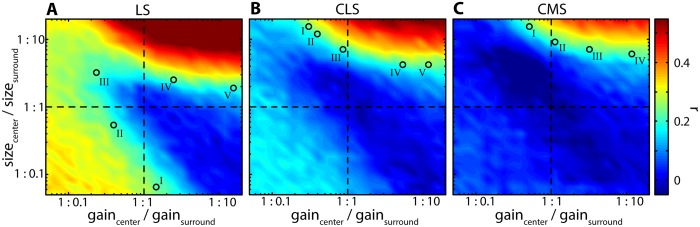
Different RF center-surround geometries give rise to similar correlations.(A-C) Spike-count correlations for t = 100 ms for LS (A), CLS (B), and CMS (C) as a function of RF surround relative gain (x-axis) and size (y-axis). At the intersection of the dashed horizontal and vertical lines RF center-surround balance is at equilibrium (i.e. equal gain and size between surround and center). Correlation magnitudes like those found experimentally (≈ 0.19; green color) were obtained for multiple and very different combinations of RF surround relative gain and size in all segments. Roman numerals (I—V) in each panel show example selected combinations of surround relative gain and size that were considered for further analyses.